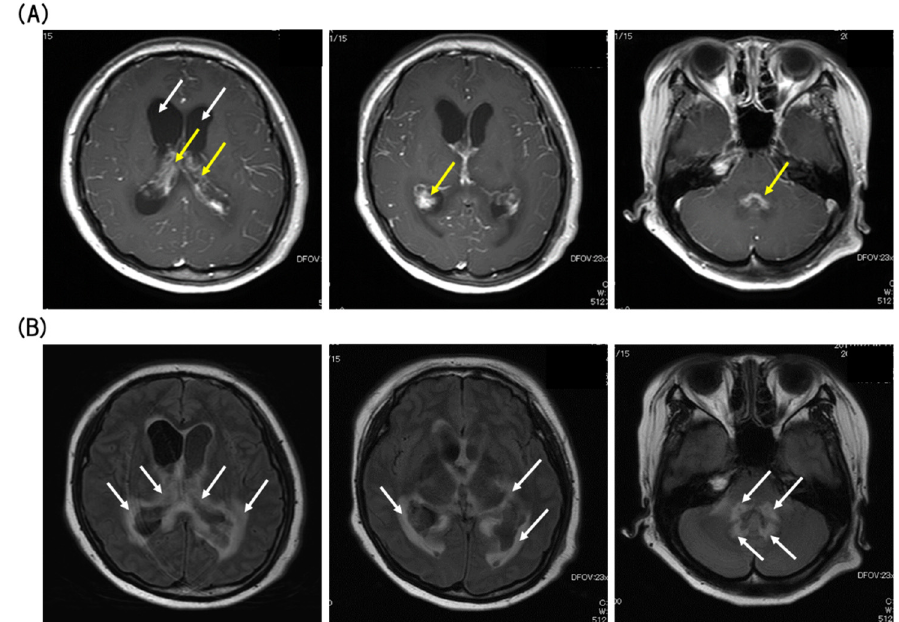
Figure 2. ( A ) T1-weighted (T1W) axial gadolinium-enhanced magnetic resonance imaging (MRI) showed Bilateral ventricle enlargement (white arrows), and hypertrophy choroid plexus (yellow arrows) with heterogeneous enhancement (axial sections). ( B ) Fluid-attenuated inversion recovery image (FLAIR) revealed high-intensity periventricular white-matter changes (white arrows) (axial sections).